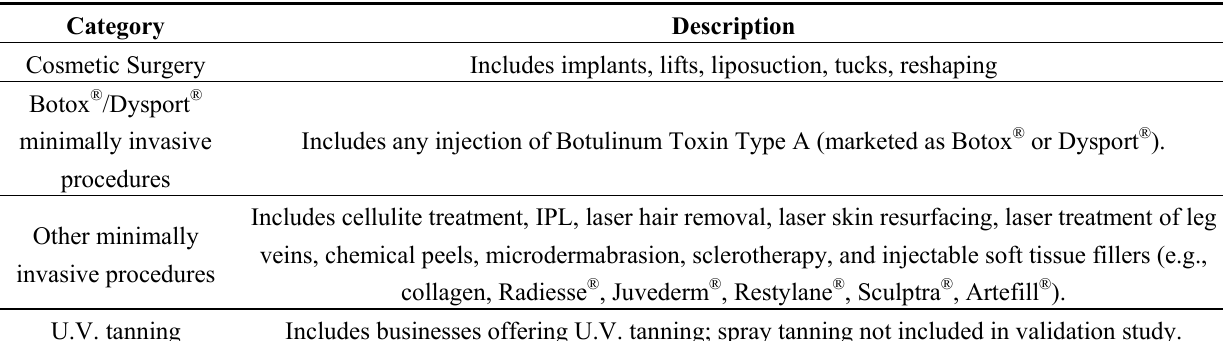
Table 1. General categorization of cosmetic procedures eligible for inclusion in business identification and mapping validation study in Boston, MA, and Seattle,